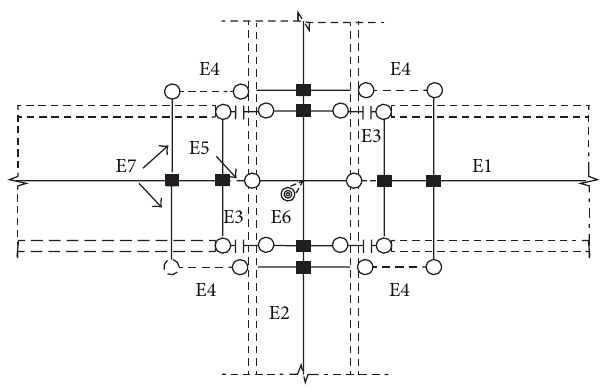
Figure 6: Modeling of posttensioned T-stub connections in